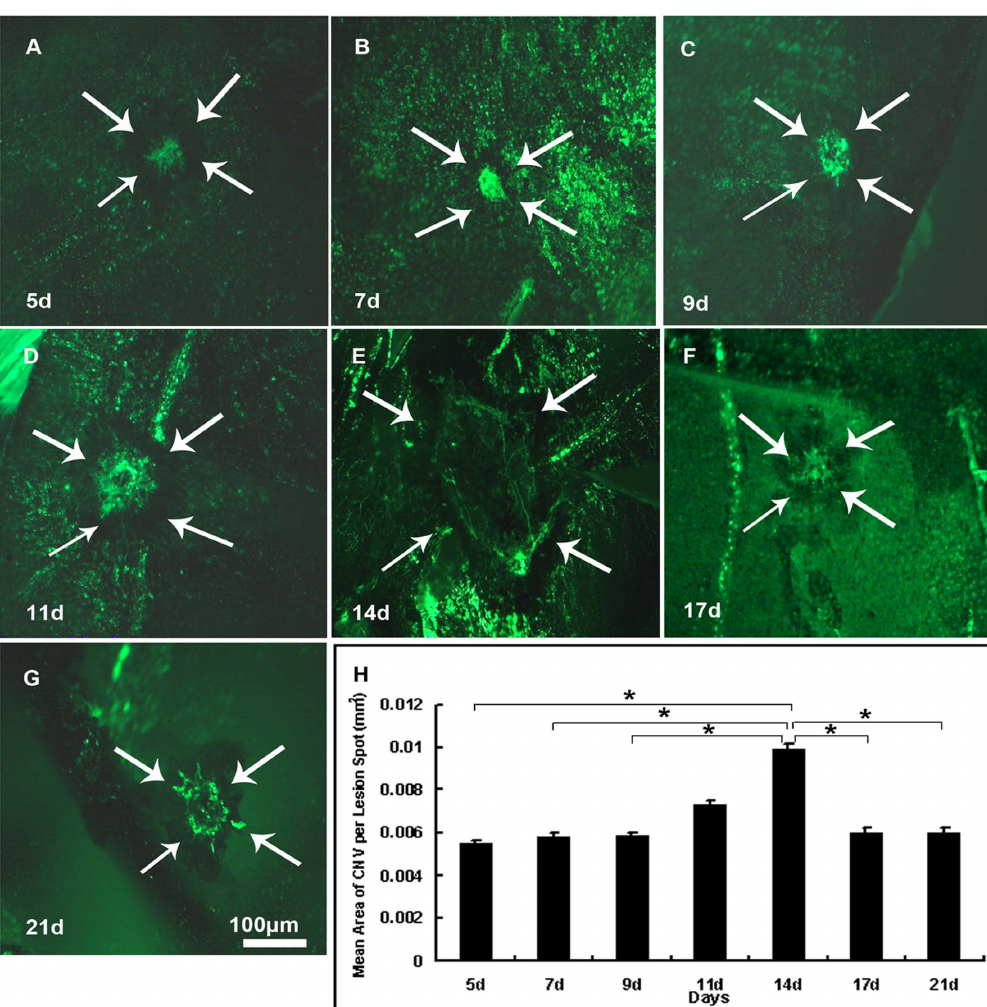
Figure 5. Mean area of CNV significantly increased at day 14 after photocoagulation. 16–20 week-old female C57BL/6 mice were given laser photocoagulation spots at 3, 12 and 9 o’clock positions 1PD away from the optic disc in the posterior pole of retina of each eye with a cover slide placed on the cornea as a contact lens. After 5, 7, 9, 11, 14, 17, 21 days, mice were perfused with fluorescein-labeled dextran and choroidal flat mounts were examined by fluorescence microscopy. The mean ( 6 SEM) area of CNV was calculated from each experimental value of each laser spot. CNV appeared from day 5 (Fig. 5A), increased significantly at day 14 (Fig. 5E, P=0.017), and decreased thereafter. Significant differences were observed of day 14 from any other point except for day11, but no significant difference was detected between day11 and any other day point Figure 5A to 5G show choroidal representative flat mounts of mice euthanized 5, 9, 11, 14, 17, 21 days after photocoagulation at 100 6 magnification. The laser spots are shown by arrows. Statistics were analyzed by one-way ANOVA with Student-Newman-Keuls method for multiple comparisons. (n=6mice/group, *P , 0.05).